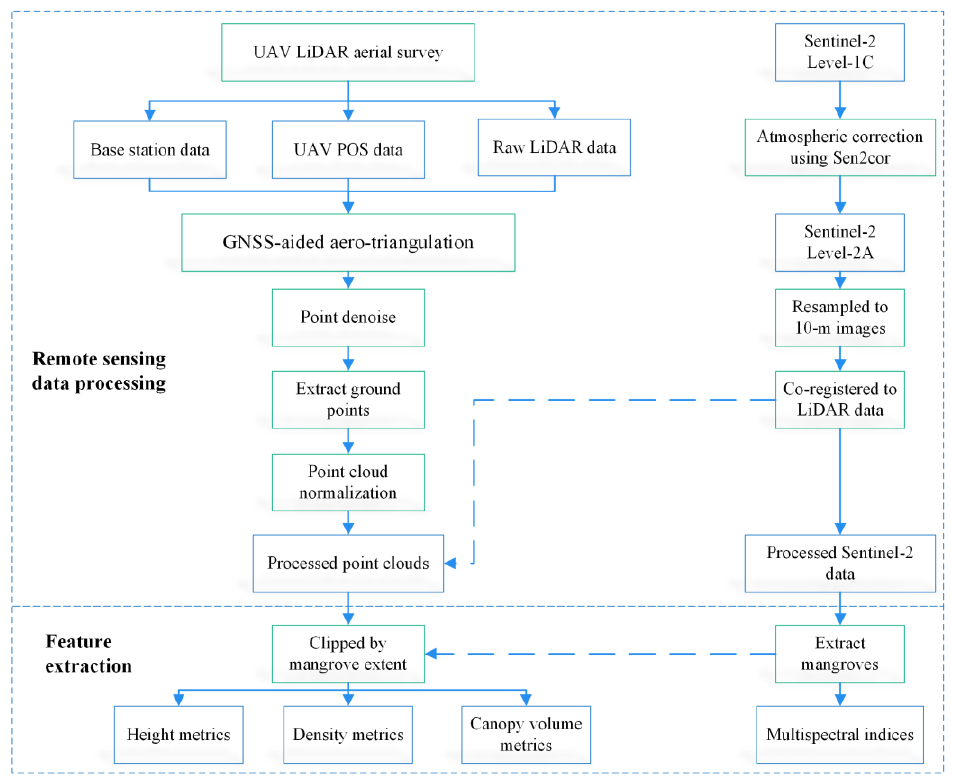
Figure 2. Workflow of UAV-LiDAR and Sentinel-2 data acquisition and processing and variable